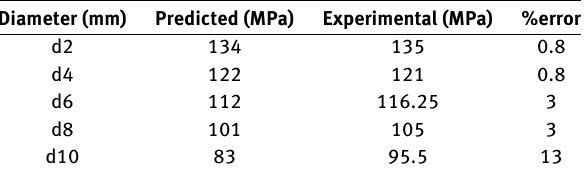
Fig. 9. Stress concentration factor